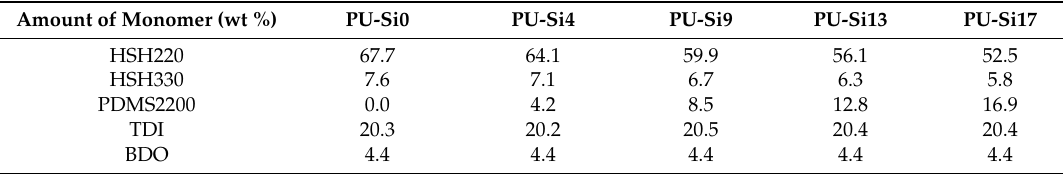
Table 2. The formulation of five